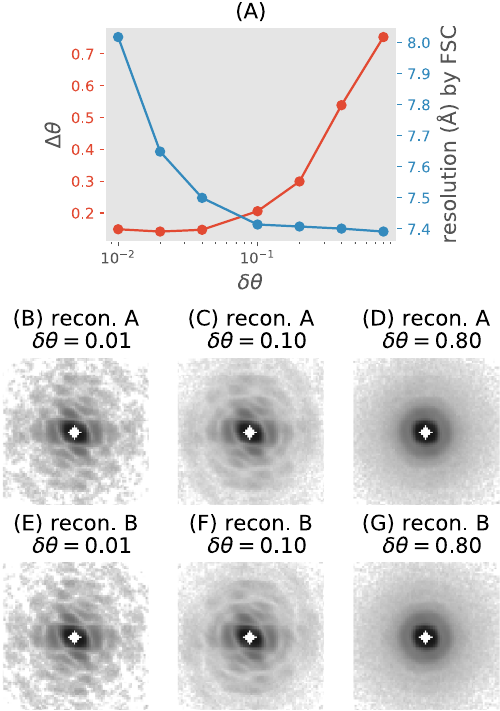
Figure 2. Fourier shell correlation (FSC) reports improved resolution despite increased orientational blurring. Two disjoint SPI datasets were simulated, A and B , each with 5000 patterns. ( A ) The FSC was calculated for all pairs of reconstructions from the same dataset and with the same orientation blurring δθ (blue curve). Diffraction volumes were reconstructed from each dataset by interpolating each pattern back into ten random orientations near the true one. The true variance of these orientations is denoted δθ 2 , which is proportional to the degree of deliberate orientation blurring. The orientation disconcurrence proposed in this paper, �θ (red curve), was computed using a third smaller sentinel dataset (1000 patterns) not used in the reconstructions. For each dataset, seven 3D volumes were reconstructed by interpolating all patterns back into the 3D diffraction volume with δθ = { 0.01, 0.02, 0.04, 0.1, 0.2, 0.4, 0.8 } . ( B – D ) The central slices of one of the seven volumes for each δθ from dataset A , ( E – G ) and those from dataset B .